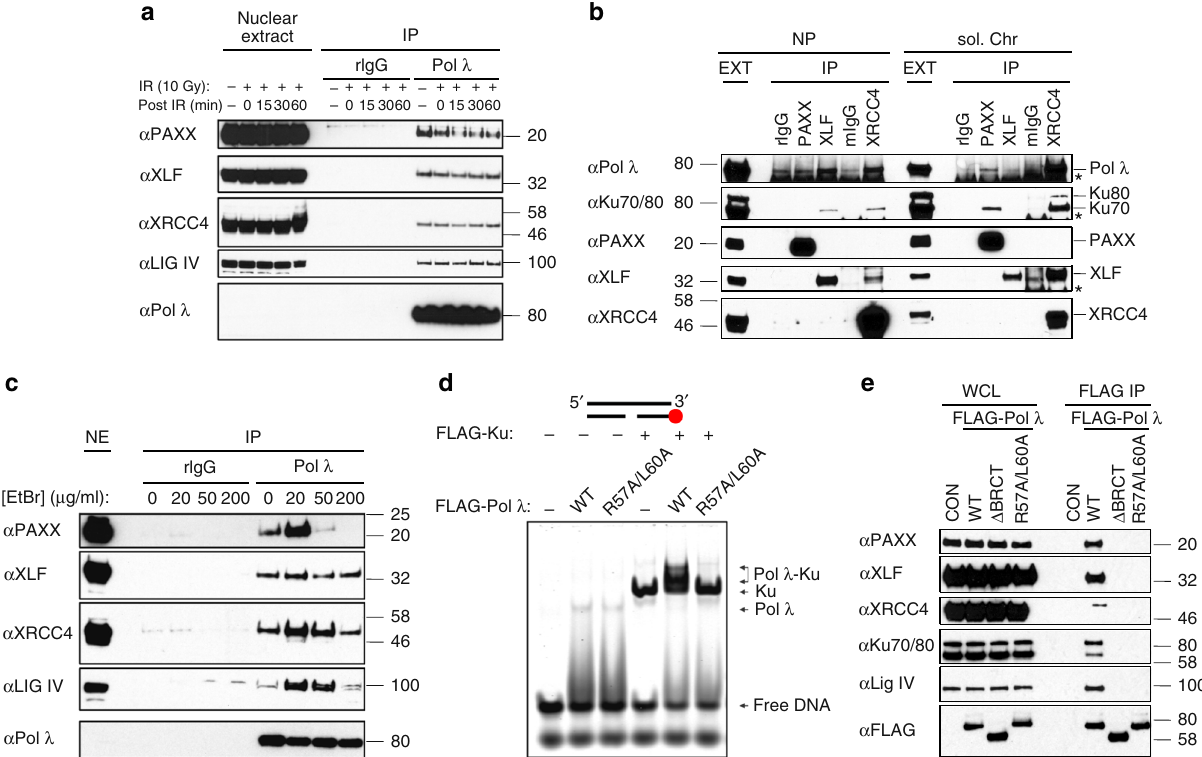
Fig. 3 Pol λ interacts with XRCC4 family proteins via its BRCT domain in cells. a HEK293F cells were irradiated with 10 Gy X-ray or left untreated. Soluble nuclear extracts were isolated following 0 – 60 min post-irradiation recovery time at 37 °C. Following IP with anti-Pol λ or rabbit IgG (rIgG), Pol λ and associated proteins were resolved by SDS-PAGE and immunoblotted for the indicated NHEJ factors. b HEK293F cell nucleoplasmic (NP) or soluble chromatin (sol. Chr) extracts were immunoprecipitated with rIgG, anti-PAXX or -XLF or mouse IgG (mIgG) or anti-XRCC4. Immunoprecipitated proteins were resolved by SDS-PAGE and immunoblotted for the indicated NHEJ factors. c As described in Panel A, except that soluble nuclear extracts were incubated with 0-200 μ g/ml EtBr for 1 h prior to IP with anti-Pol λ or rIgG. d EMSA showing that interaction of Pol λ with DNA-bound Ku requires R57 and L60 in the BRCT domain of Pol λ . Reactions were performed with IRDye ® 700-labelled 5nt-gapped dsDNA (33-mer) in the presence or absence of FLAG- Ku70/80 (20 nM) and either FLAG-Pol λ -WT or a R57A/L60A mutant (50 nM). e HEK293F cells were transiently transfected with either pCMX-LacZ (control) or pCMX-FLAG-Pol λ -WT, - Δ BRCT or a R57A/L60A mutant and anti-FLAG IPs